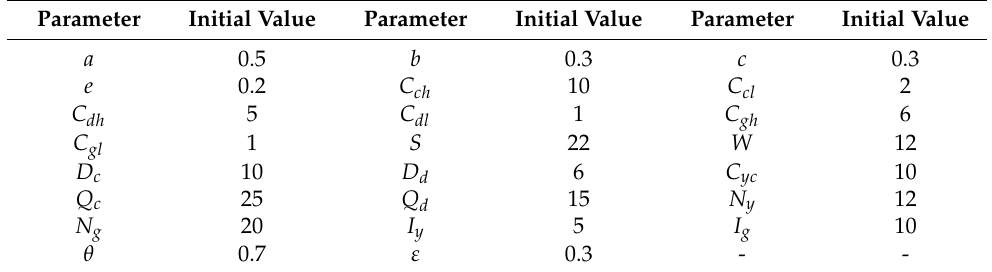
Table 4. Model parameter setting.